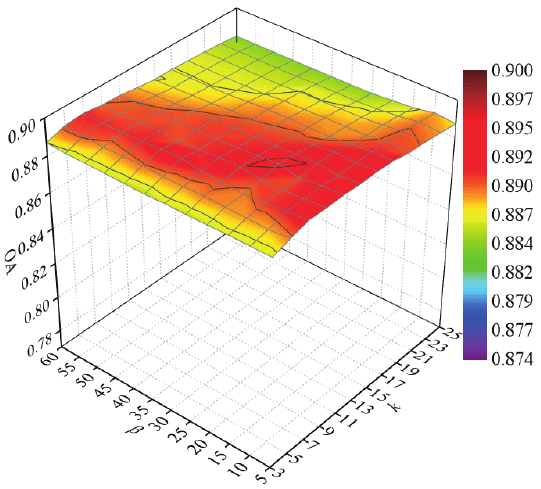
Figure 8. OAs with respect to different numbers of neighbors on the Salinas data set.